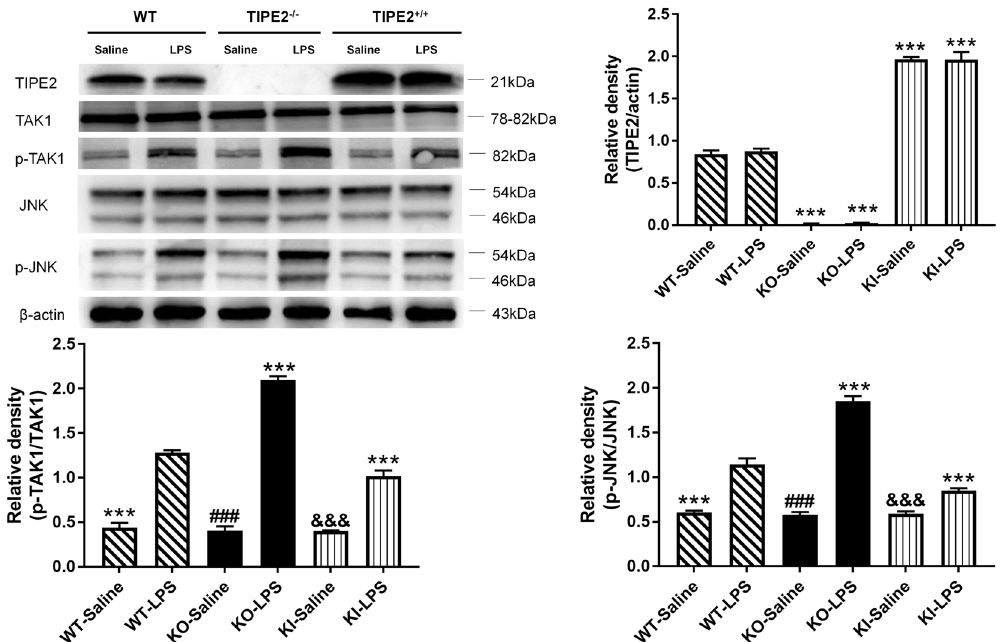
Fig. 8 Downregulation of TIPE2 on the TAK1/JNK signaling pathway in DCs in vitro. DCs with different TIPE2 genetic designs were treated by the same dose of LPS or saline in vitro. Expressions of TIPE2, TAK1, JNK as well as phosphorylation of both TAK1 and JNK were determined by western blotting, and β -actin served as the internal standard. Values of three independent experiments are represented as mean ± SD ( n = 5 in each group). Statistical signi fi cances: compared with the WT-LPS group, *** P < 0.001; compared with the KO-LPS group, ### P < 0.001; compared with the KI-LPS group, &&& P <